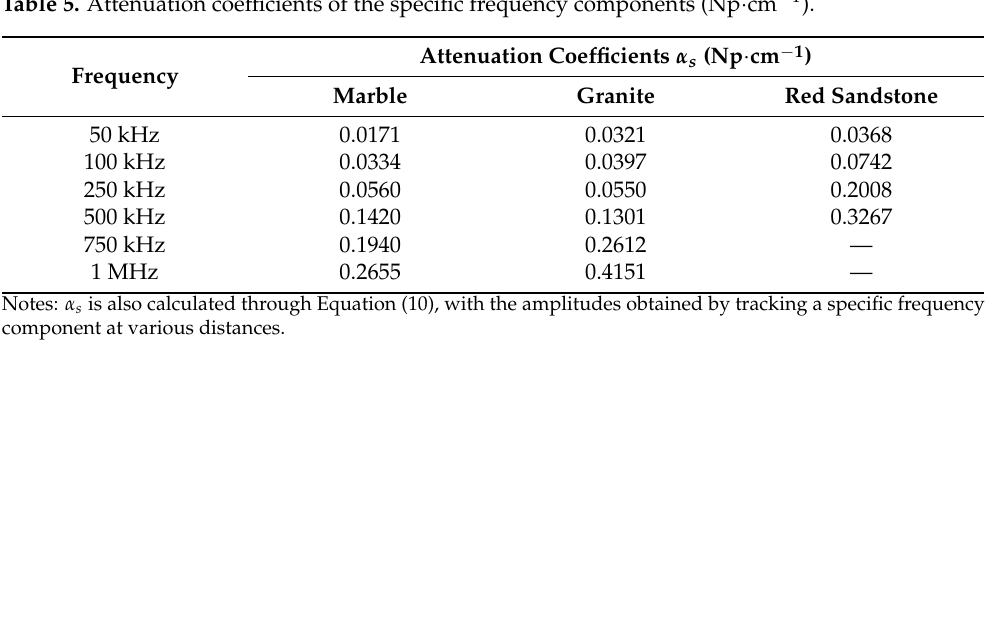
Table 5. Attenuation coefficients of the specific frequency components (Np · cm − 1